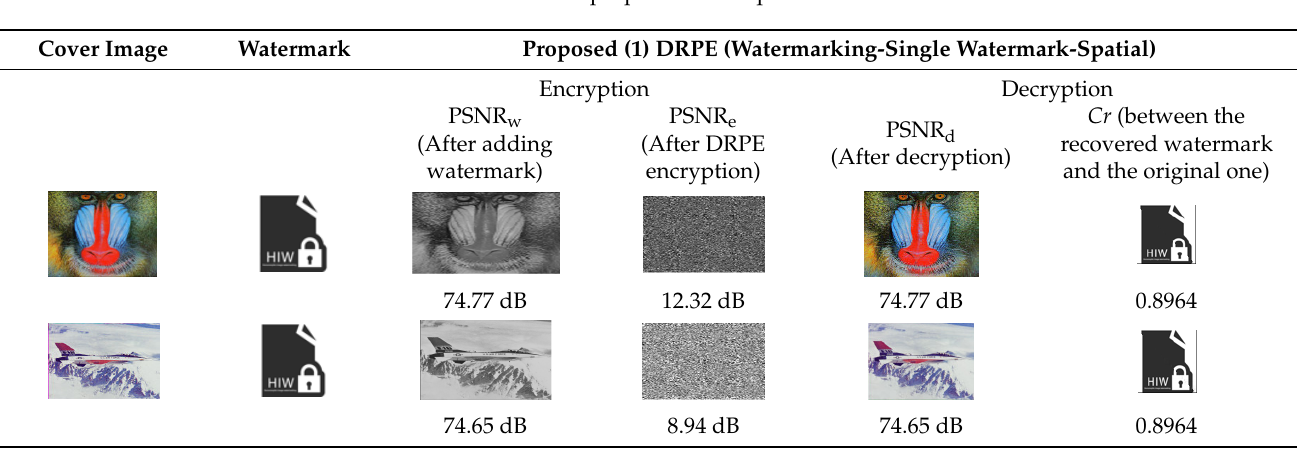
Table 6. Results of the first proposed technique based on